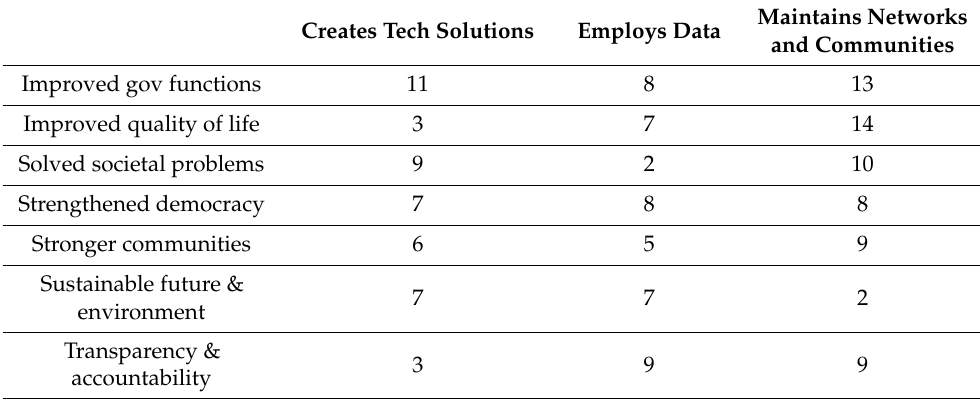
Table 6. The Distribution of Platforms in the Sample Based on Dimensions of Methods and Goals. Creates Tech Solutions